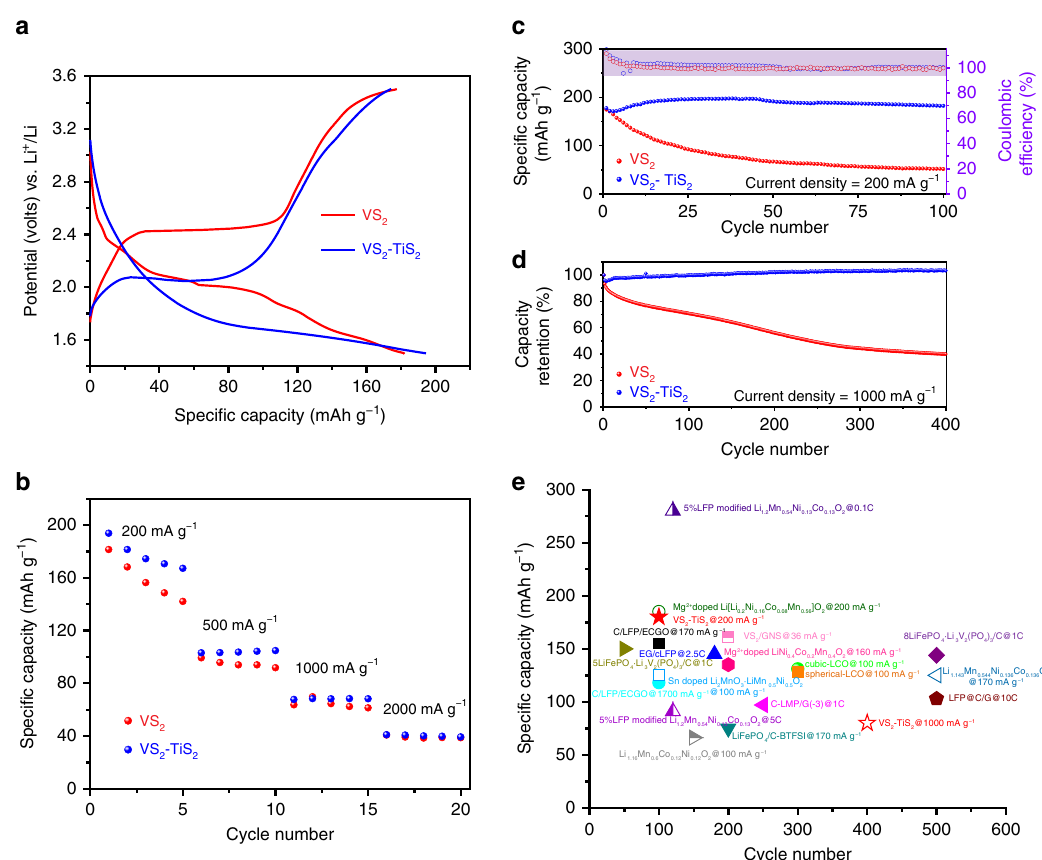
Fig. 3 Electrochemical characterization. a The galvanostatic charge – discharge voltage pro fi les of the VS 2 electrode and VS 2 -TiS 2 electrode between 1.5 and 3.5 V (vs. Li/Li + ) at a current density of 200 mA g − 1 . b Rate performance of the VS 2 and VS 2 -TiS 2 electrodes. c Cycling performance and Coulombic ef fi ciency of VS 2 electrode and VS 2 -TiS 2 electrode at 200 mA g − 1 . d Capacity retention of VS 2 electrode and VS 2 -TiS 2 electrode at 1000 mA g − 1 . e Comparison of the VS 2 -TiS 2 electrode (starred) with other commonly used cathodes [7, 37, 38, 39, 40, 41, 42, 43, 44, 45, 46, 47, 48, 49] in Li-ion batteries. The y -axis on the plot gives the speci fi c capacity achieved by the cathode material at the completion of a speci fi ed number of charge − discharge cycles given on the x -axis of the plot. The charge − discharge rate (or current density) at which the electrode is cycled is also speci fi ed next to each data point on the